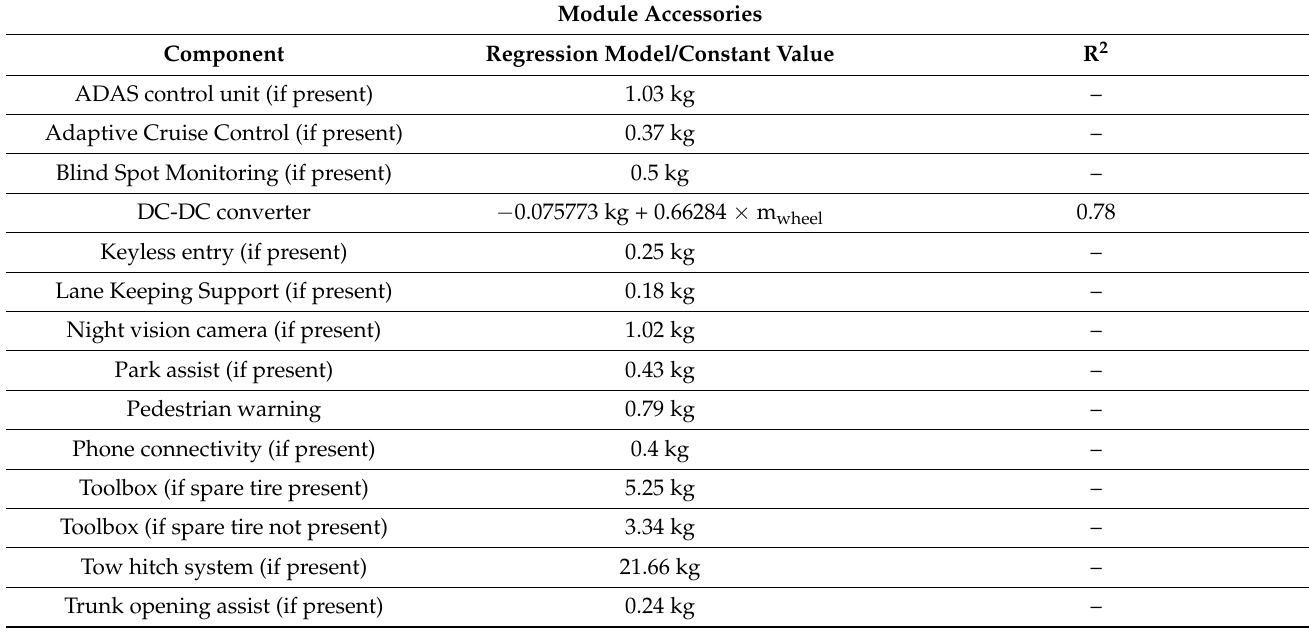
Table A9. Empirical models for the Accessories module. All the accessories (except for the pedestrian warning, which is always present for BEVs) are optional and can be activated/deactivated using the set of optional inputs shown in Table